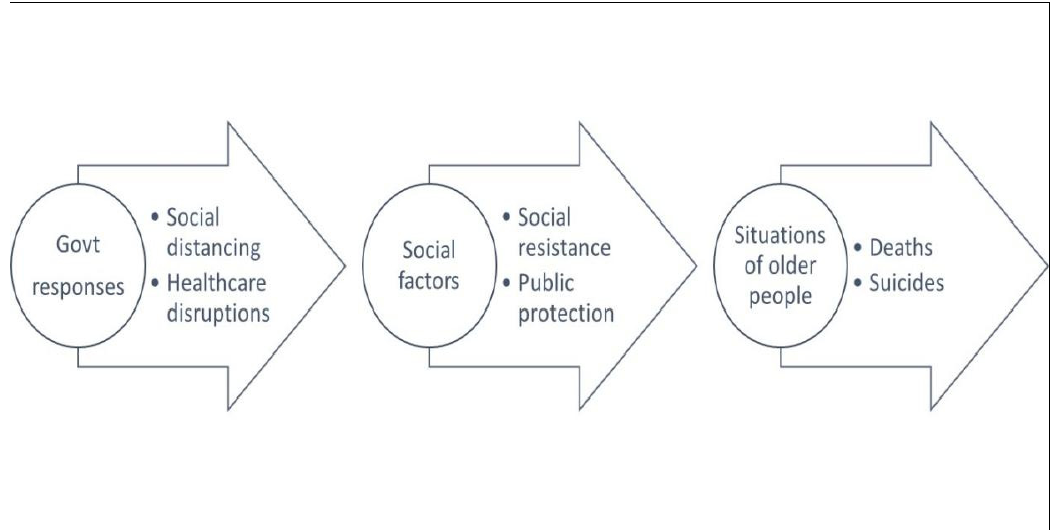
Figure 2. Framework of study.